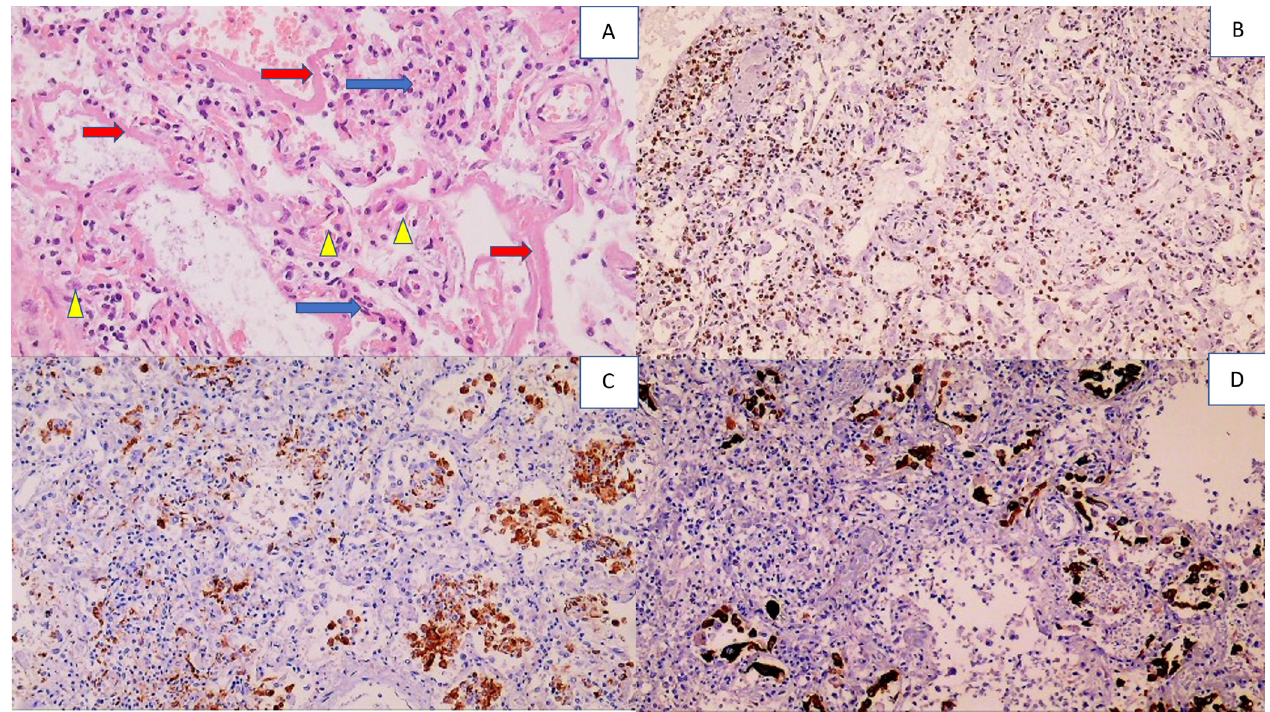
Figure 1. Histology and immunohistochemistry of the lungs with diffuse alveolar damage (DAD). Photo ( A ) shows lymphocyte-infiltrated alveolar septa (blue arrows), hyaline membranes lining the alveolar septa (red arrows), and alveolar macrophages (yellow arrowheads), (HE, (hematoxylin-eosin staining) 200 × ). Photo ( B ) shows infiltration of immunohistochemically CD3-positive T lymphocytes in the alveoli (DAB (3, 3,-diaminobenzidine) positivity presented in brown, with blue con- trast staining with hematoxylin 100×). Photo ( C ) shows numerous alveolar macrophages that are immunohistochemically CD68 positive (100×). Photo ( D ) shows numerous desquamated pneumo- cytes in the alveoli that are immunohistochemically AE1AE3 positive (100×).